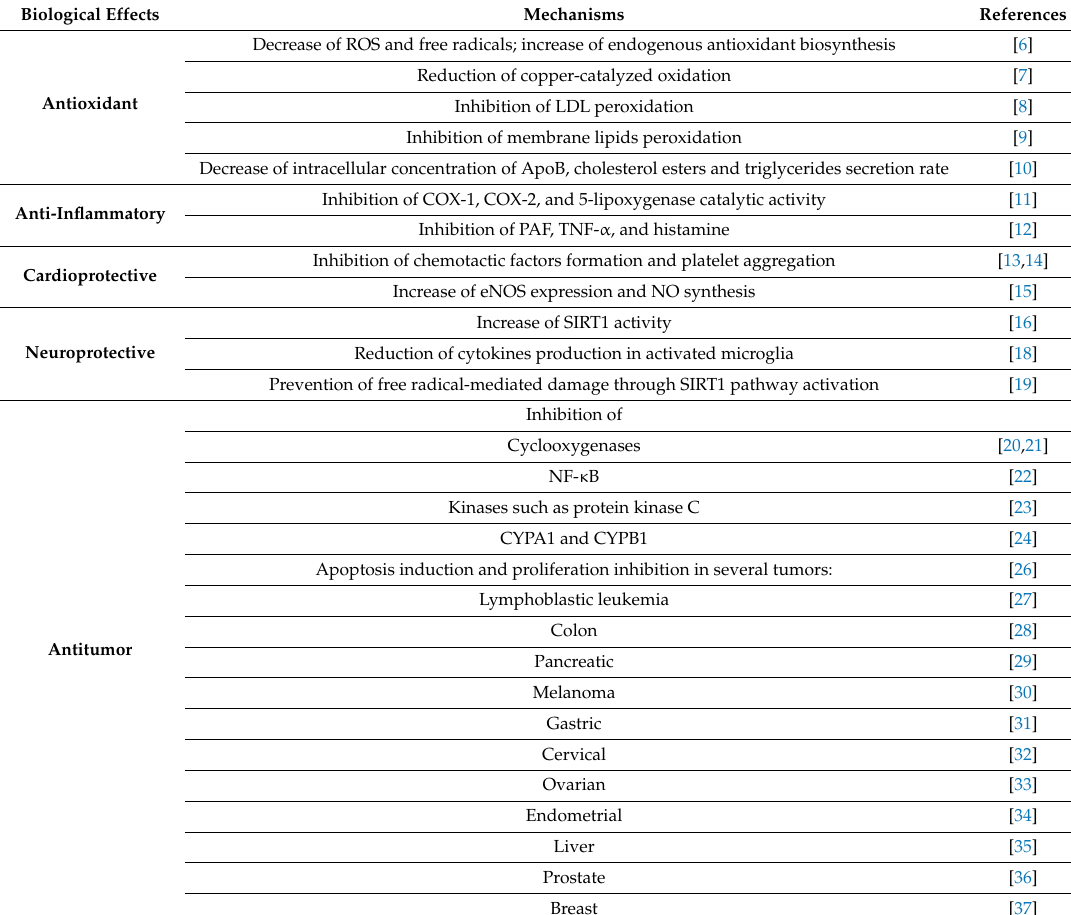
Table 1. Principal mechanisms through which resveratrol exerts its biological